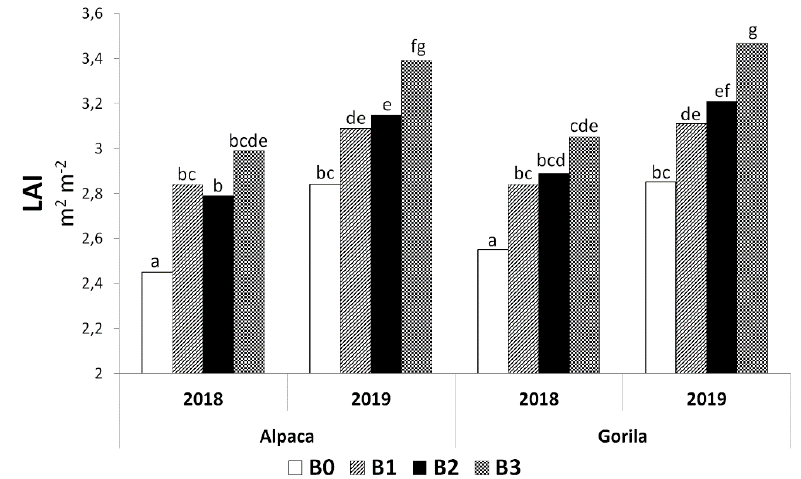
Figure 8. Interactions between biostimulants, years, and varieties for leaf area index (LAI). B0—